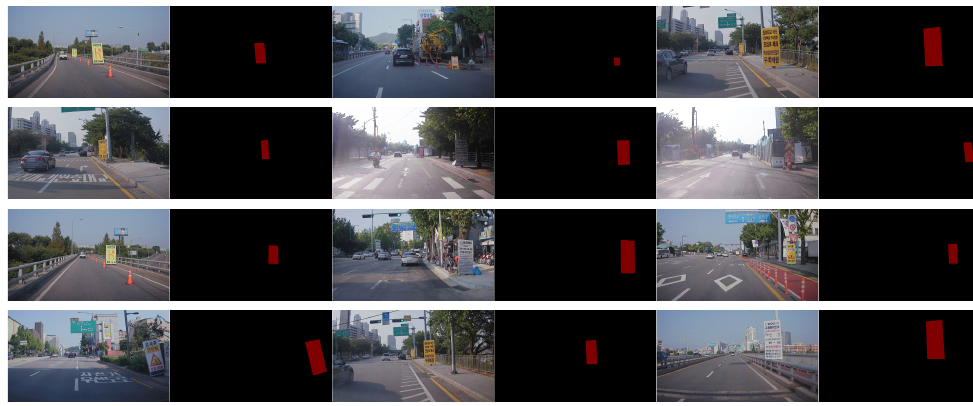
Figure 4. Collected in-domain construction